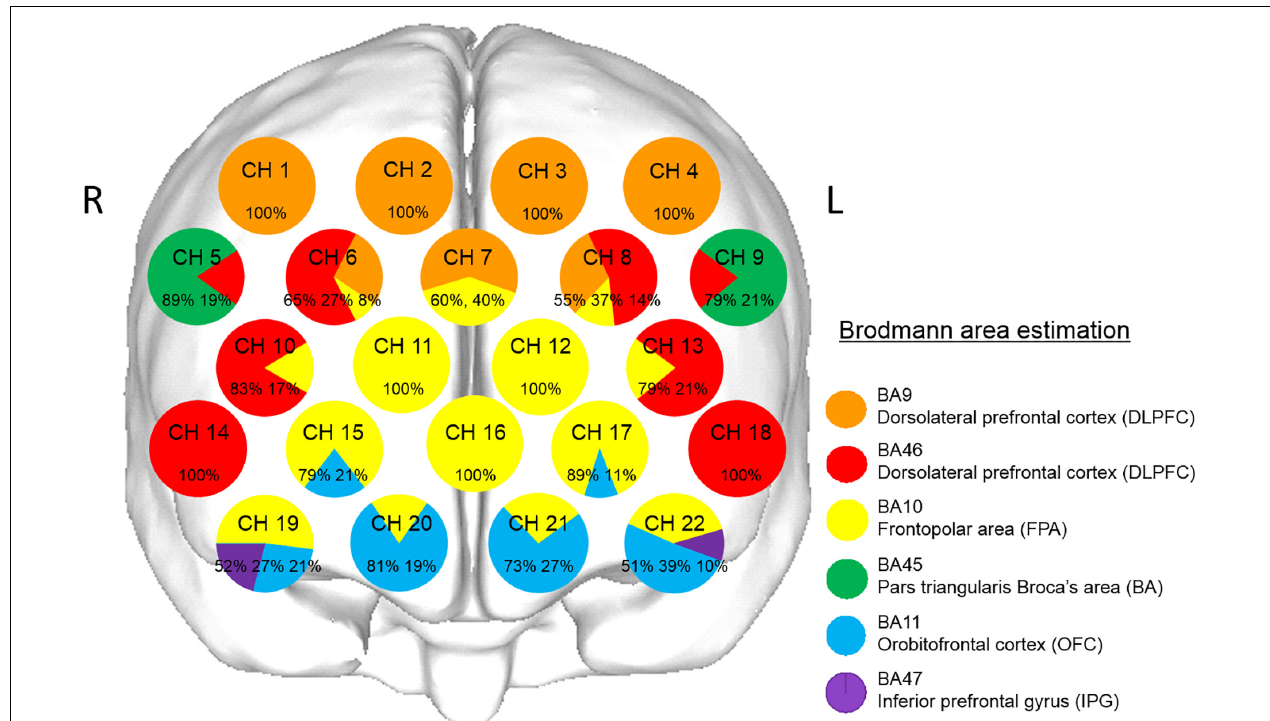
FIGURE 2 | Anatomical identification of near-infrared spectroscopy channels. The coordinates for all probe and anatomical landmark positions (Nz, Iz, A1, A2, and Cz) were obtained using a three-dimensional digitizer. Probabilistic registration was used to transcribe the measuring points for each subject according to the protocol of the Montreal Neurological Institute, and those points were projected onto the cortical surface. Anatomical localization was identified using the Platform for Optical Topography Analysis Tools, with reference to the Automated Anatomical Labeling system. Orange, red, yellow, green, blue, and purple represent DLPFC (BA9), DLPFC (BA46), FPA (BA10), BA (BA45), OFC (BA11), and IPG (BA47), respectively. Each circle corresponds to a channel, and the pie chart within each circle shows the percentages of areas in that channel.